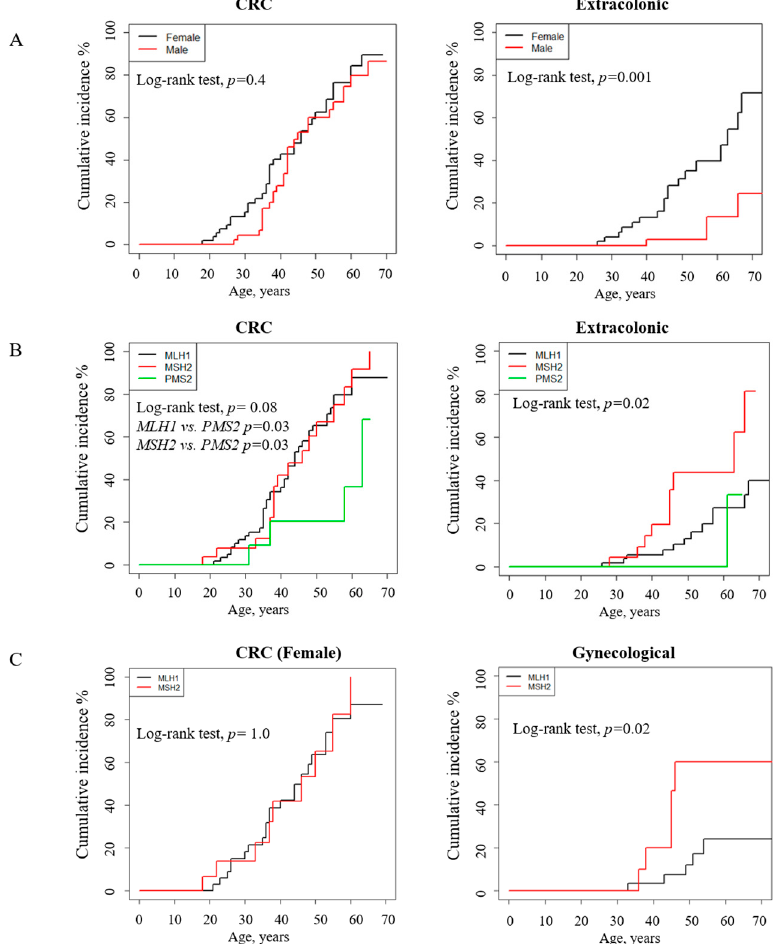
Figure 4. Cumulative incidence for first cancer diagnosed before 75 years in path_MMR carriers (Group 2) according to ( A ) gender, ( B ) gene and ( C ) females with path_MLH1 and path_MSH2 .